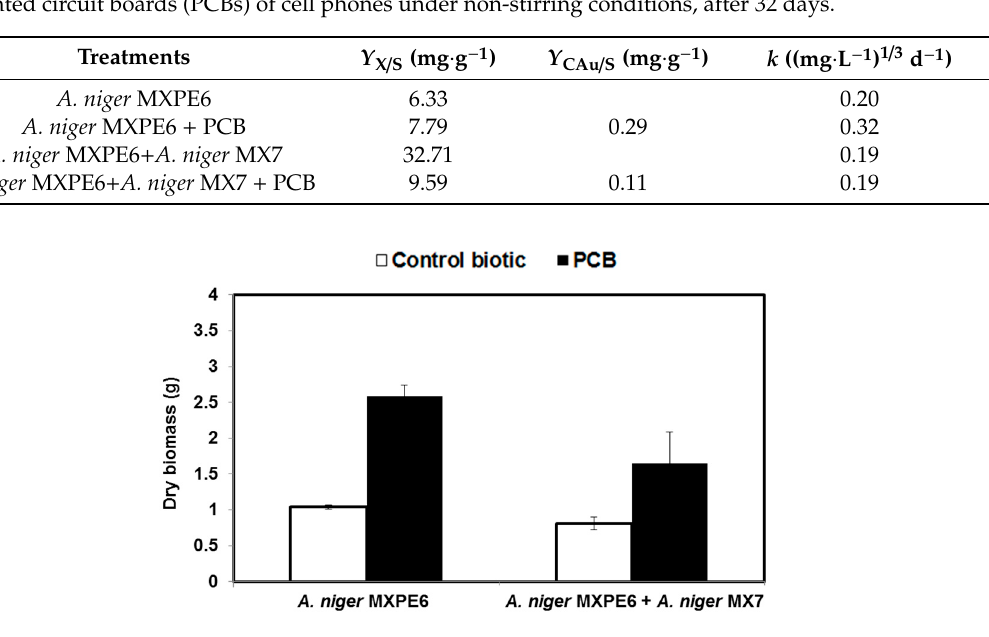
Figure 2. Concentration of protein in the culture medium of treatments with and without PCB: ( A ) A. niger MXPE6; ( B ) fungal consortium ( A. niger MXPE6 + A. niger MX7). Data are given as means ± standard error; n = 3.